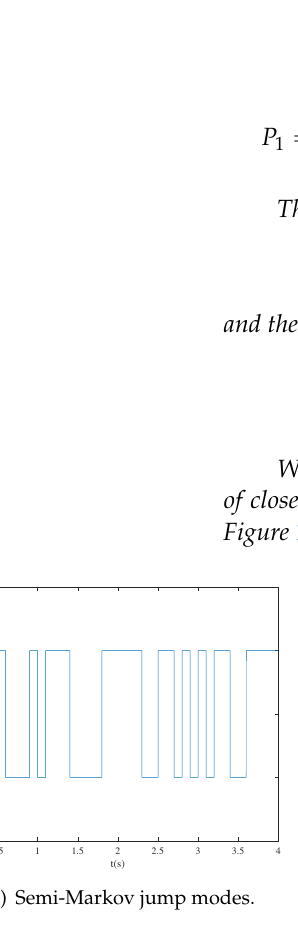
Figure 1. The closed-loop SSMJS with ω ( t ) =